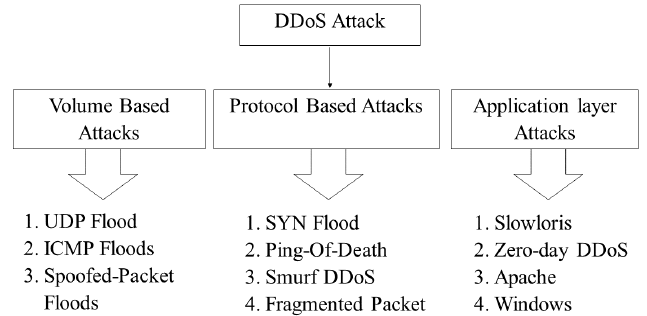
Figure 1. Distributed denial-of-service (DDoS) attacks classification